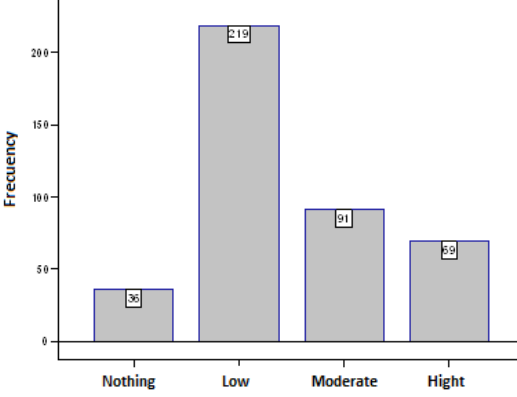
Figure 1. Fear of falling